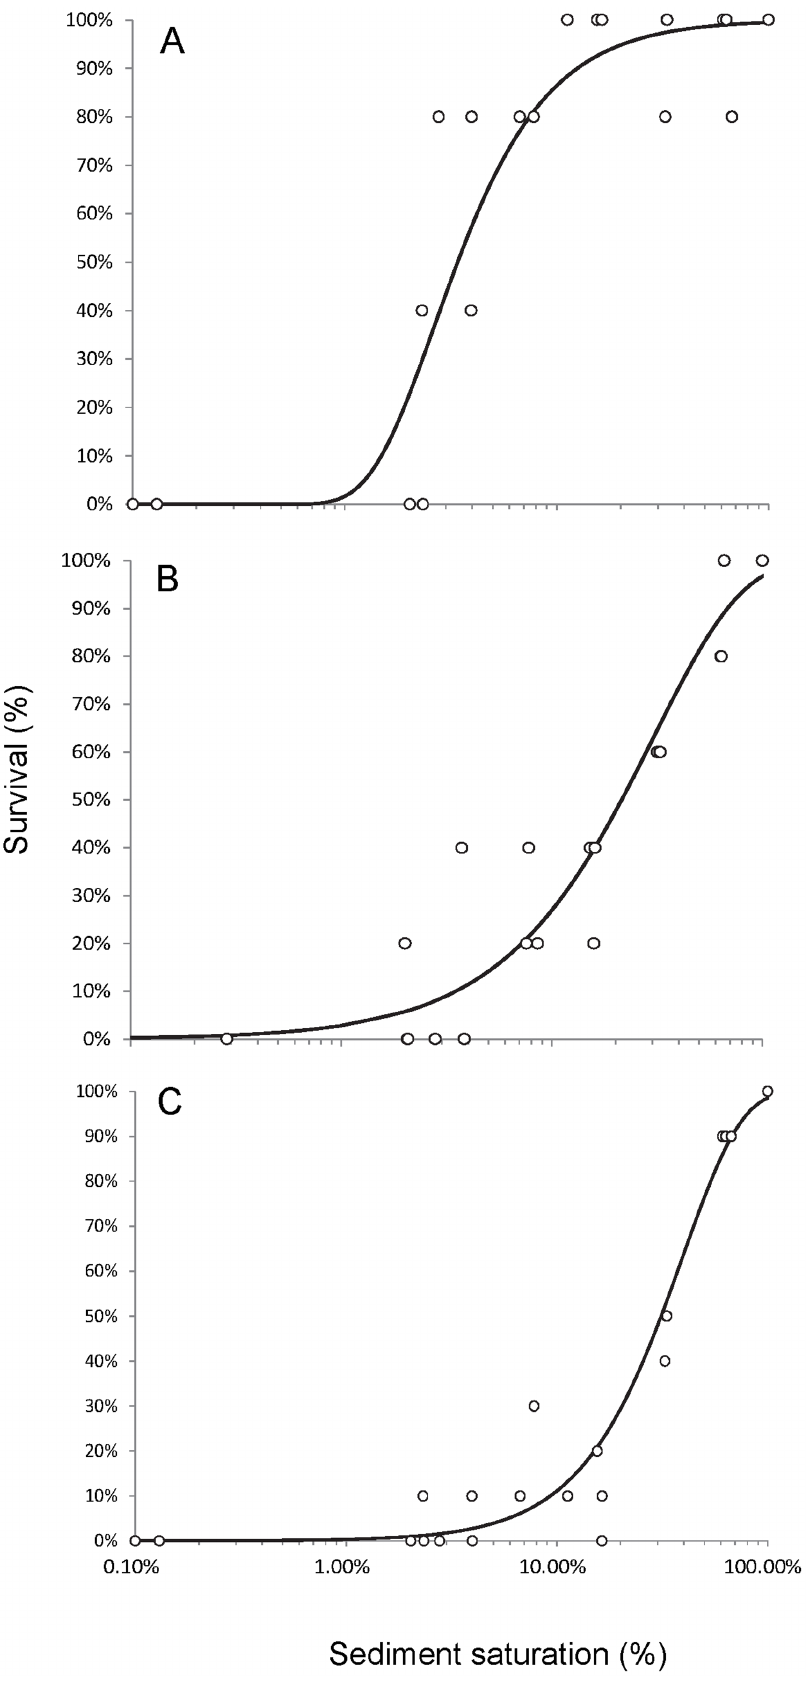
Figure 5. Survival rate of stygofauna depending on the sediment saturation level. Response of A - the Wellington syncarids, B - the Wellington copepods and C - the Budderoo swamp copepods to decreased sediment saturation for 48 h. doi:10.1371/journal.pone.0078502.g005 PLOS ONE |